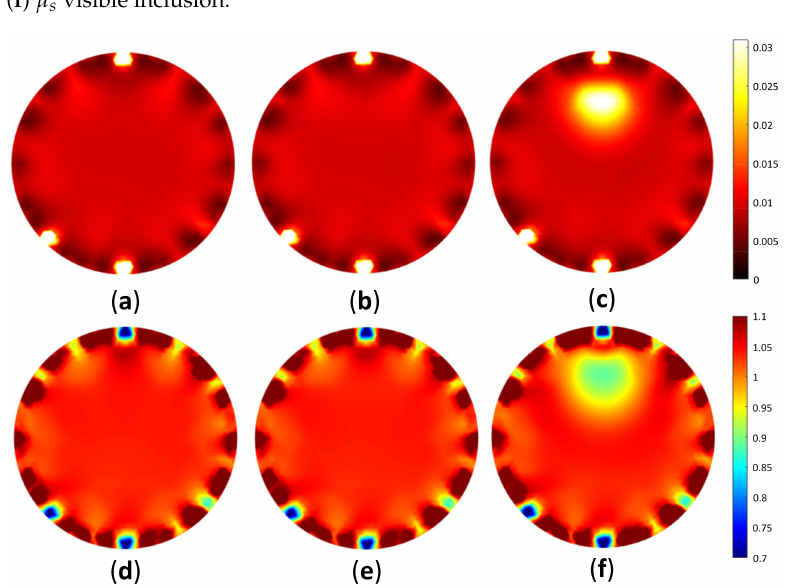
Figure 10. Reconstructed image of case A2, as shown in Table 1, representing ( a ) µ a